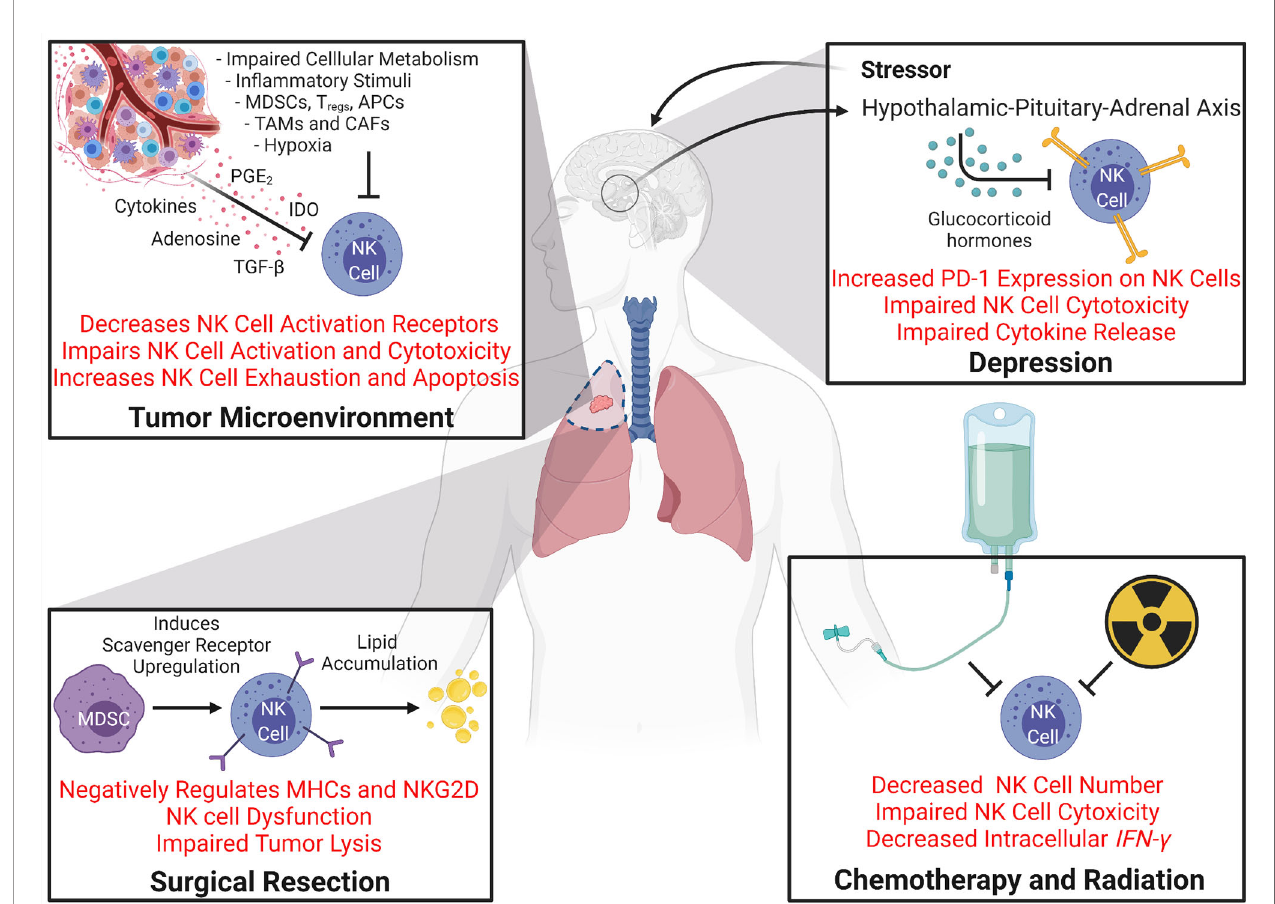
FIGURE 4 | Mechanisms Driving NK Cell Dysfunction During Cancer. Many processes that occur during cancer and cancer therapy can cause dysfunction of NK cells. The tumor microenvironment itself creates a setting full of NK cell inhibitory mechanisms. Impaired cellular metabolism increased in fl ammatory stimuli, hypoxia, and the localized immunosuppressive cells all can promote NK cell deactivation and impair NK cytotoxicity. Secreted molecules like cytokines, adenosine, TGF- b , prostaglandin E2 (PGE2) (5), and Indoleamine 2,3-dioxygenase (IDO) in the tumor milieu also promote NK cell downregulation, exhaustion, and apoptosis [reviewed in 138)]. Secondary effects of cancer and cancer therapy, such as depression can also affect NK cell function. Stressors can activate glucocorticoid hormone production via the hypothalamic-pituitary-adrenal axis which can induce PD-1 expression on NK cells and impairs NK cell cytotoxicity and cytokine release. Cancer therapies such as chemotherapy, radiation, and surgical resection can all cause NK cell dysfunction. Both chemotherapy and radiation have been shown to decrease NK cell population and impair NK cell cytotoxicity and IFN - g levels. Surgical resection and perioperative factors have been shown to impair NK cell function. For example, increases in immunosuppressive cell populations such as MDSCs induce scavenger receptor expression on NK cells which promotes lipid accumulation which negatively regulates NK cell receptors and results in NK cell